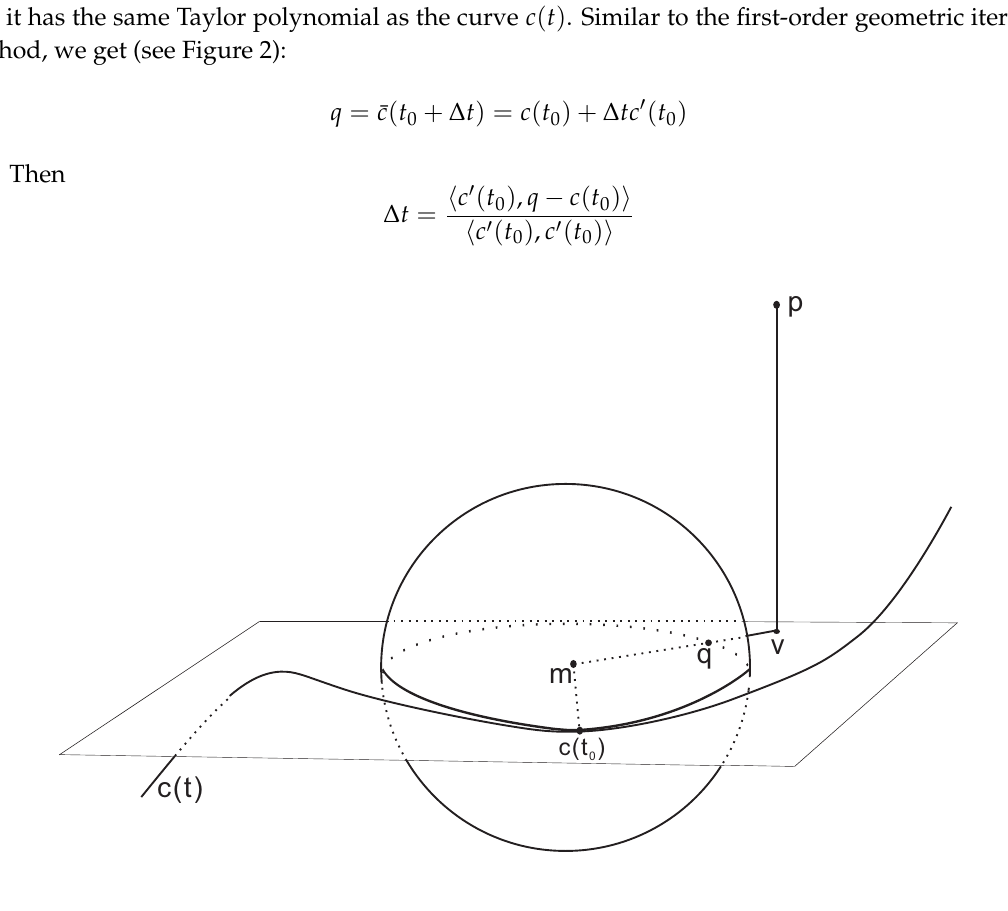
Figure 2. Illustration of the second-order geometric iteration for computing the minimum distance between a point and a spatial parametric